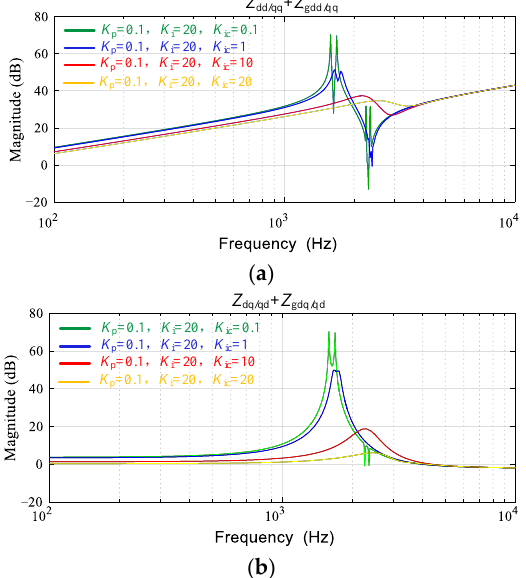
Figure 11. Impedance Bode plots under different parameters of a capacitor current regulator. ( a ) Impedance characteristics on the main diagonal. ( b ) Impedance characteristics on the subdiagonal.